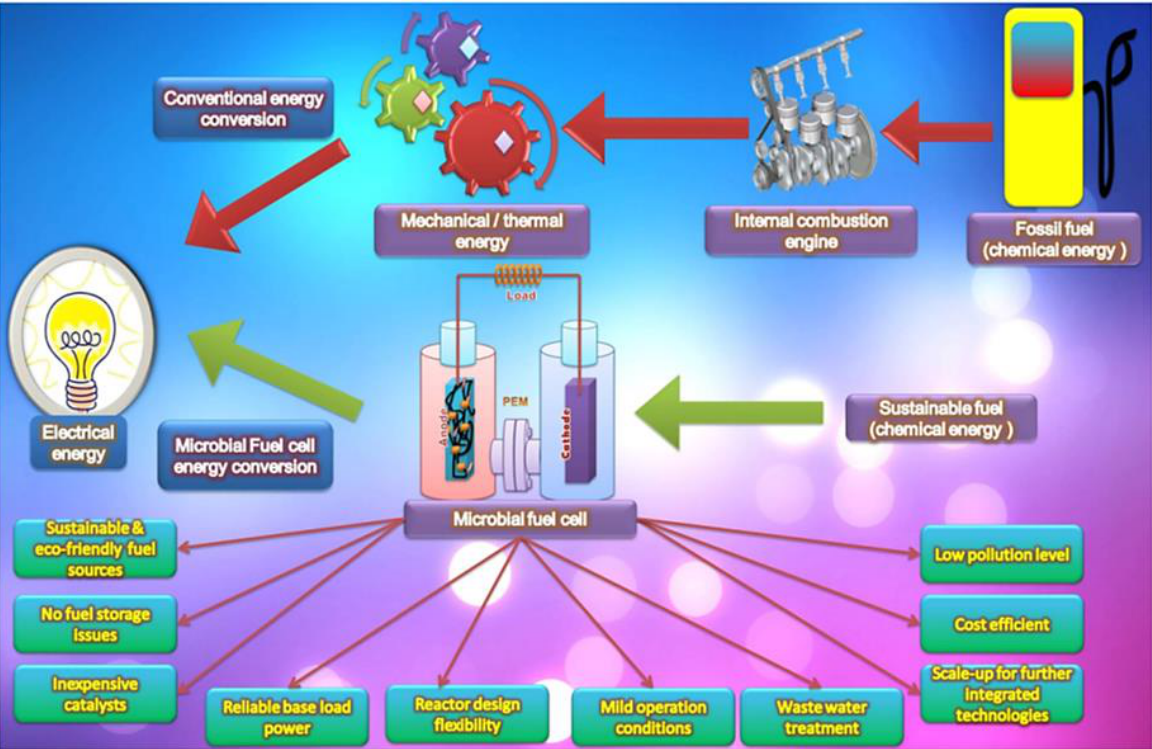
Figure 8. Energy diagram of energy devices and benefits of microbial fuel cells [135]. Reproduced with permission from Elsevier.